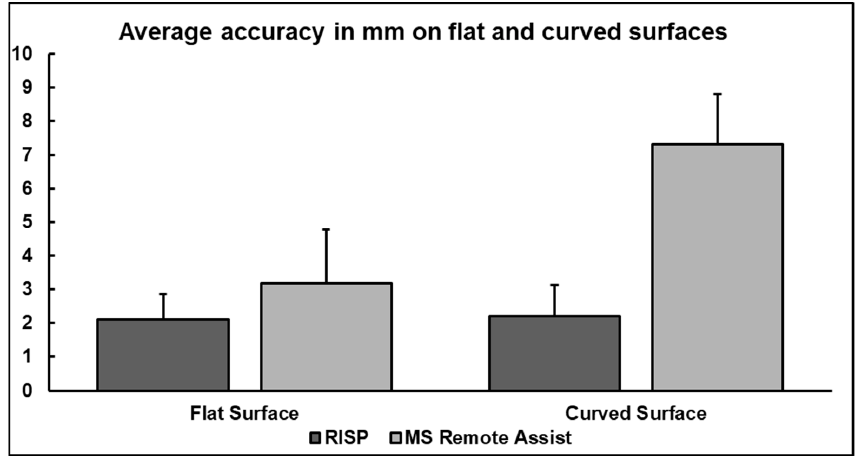
Figure 4. A bar chart visualizing the average accuracy of the RISP and MS Remote Assist on flat and curved surfaces. Values in mm. Error bars represent standard deviation (smaller = better).